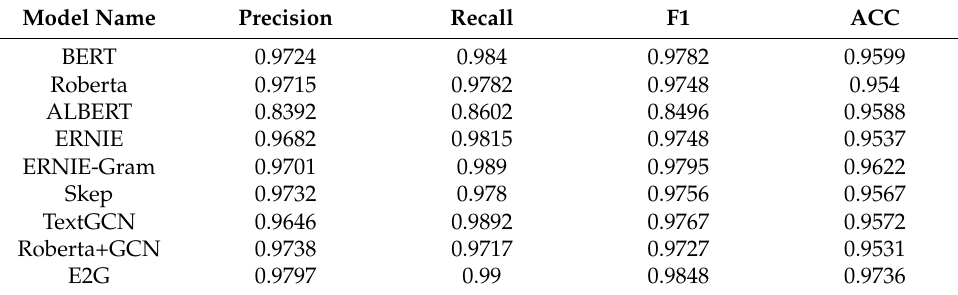
Table 5. Performance of different models on CAEIE.